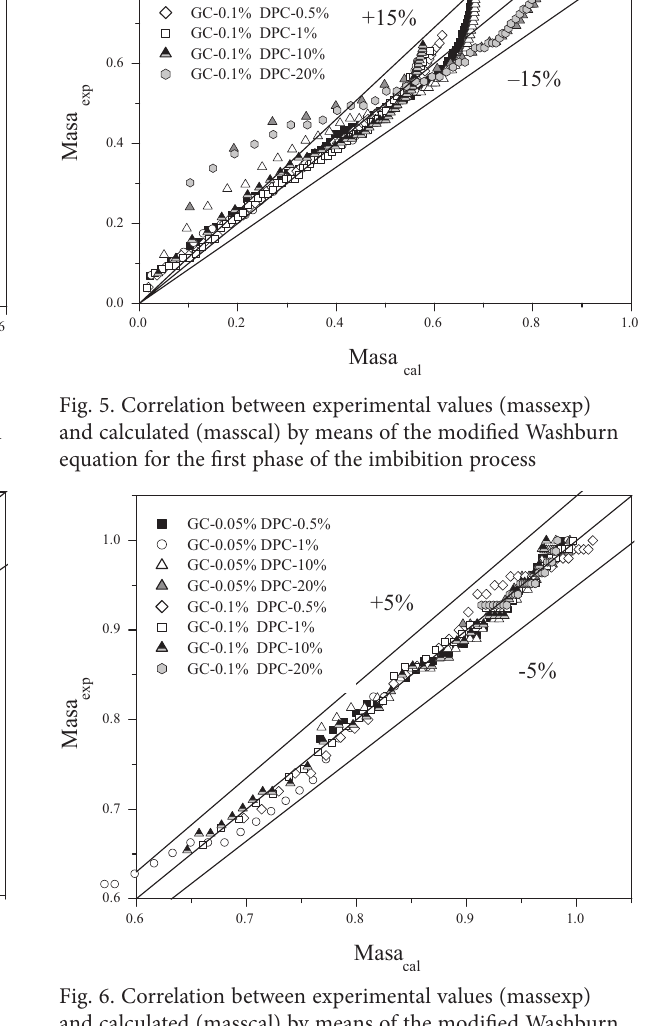
equation for the second phase of the imbibition process